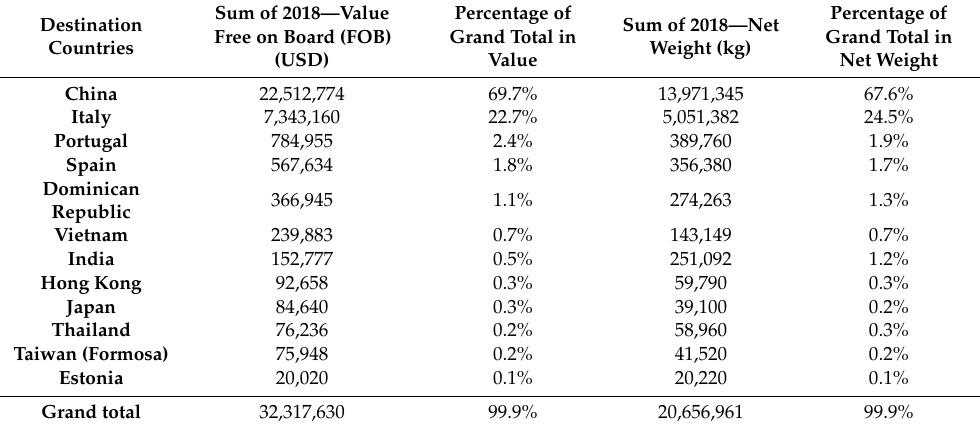
Table 1. Wet-blue exports from the Pará state in 2018, in net value (USD), net weight (kg) and percentages relative to the grand total. [48].